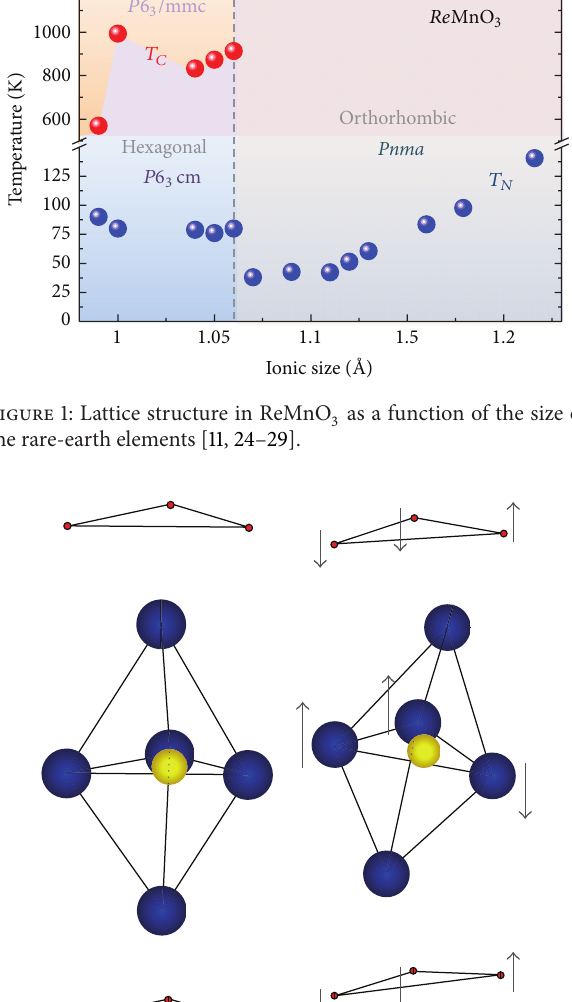
𝑃6 3 cm space group.